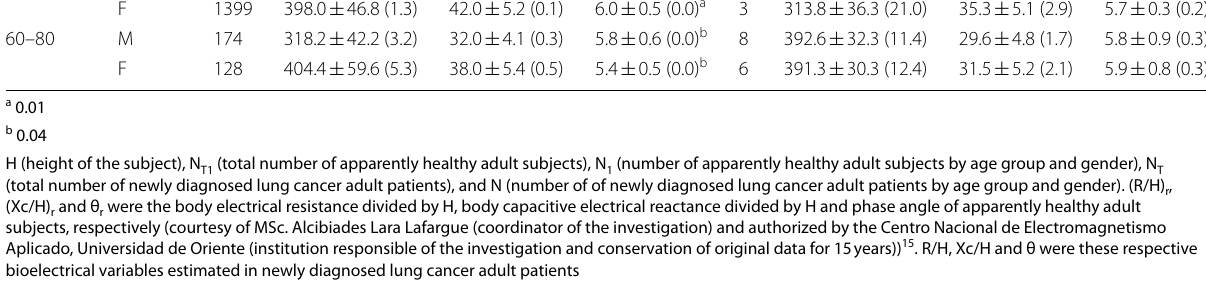
values of (R/H) r and (Xc/H) r and lower values of θ r than men AHASs for each age group, being noTable for the Table 3 showed the mean standard deviation (stand- 17 to 59 age group. Furthermore, men and women of the ± 60 to 80 age group showed higher values of (R/H) r , and ard error of the mean) of R/H, Xc/H and θ (for NDL- lower values of (Xc/H) r and θ r than those of the 17 to 59 CAPs), and (R/H) r , (Xc/H) r and θ r (for AHASs) by age group and gender. Women AHASs, women had higher age group for each gender. For both age groups, female